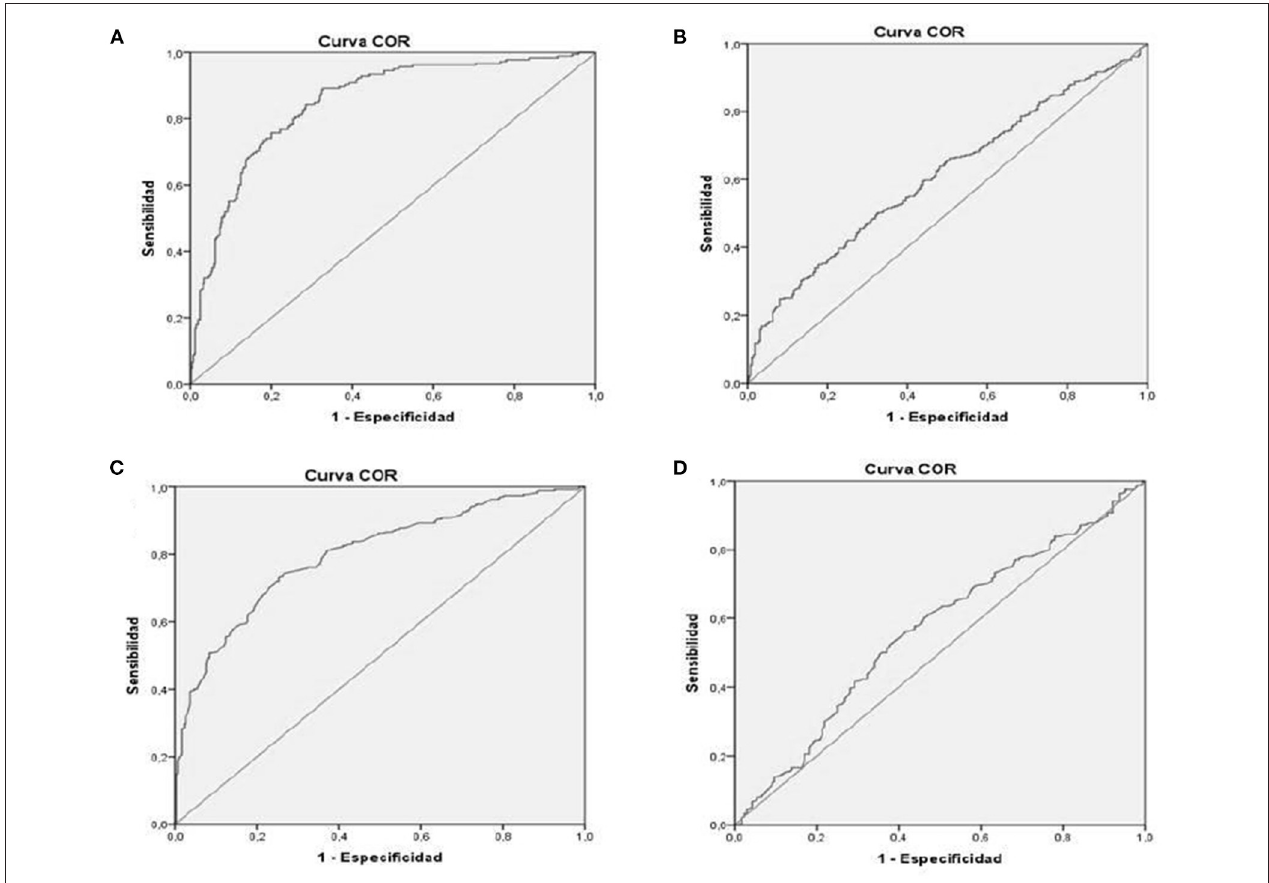
FIGURE 2 | ROC cube: relationship between decrease Z score in the first 28 days of life and risk of EUGR (A) INTERGROWTH-21st dynamic-EUGR. (B) INTERGROWTH-21st static-EUGR. (C) Fenton dynamic-EUGR. (D) Fenton static-EUGR). EUGR, Extrauterine growth restriction.